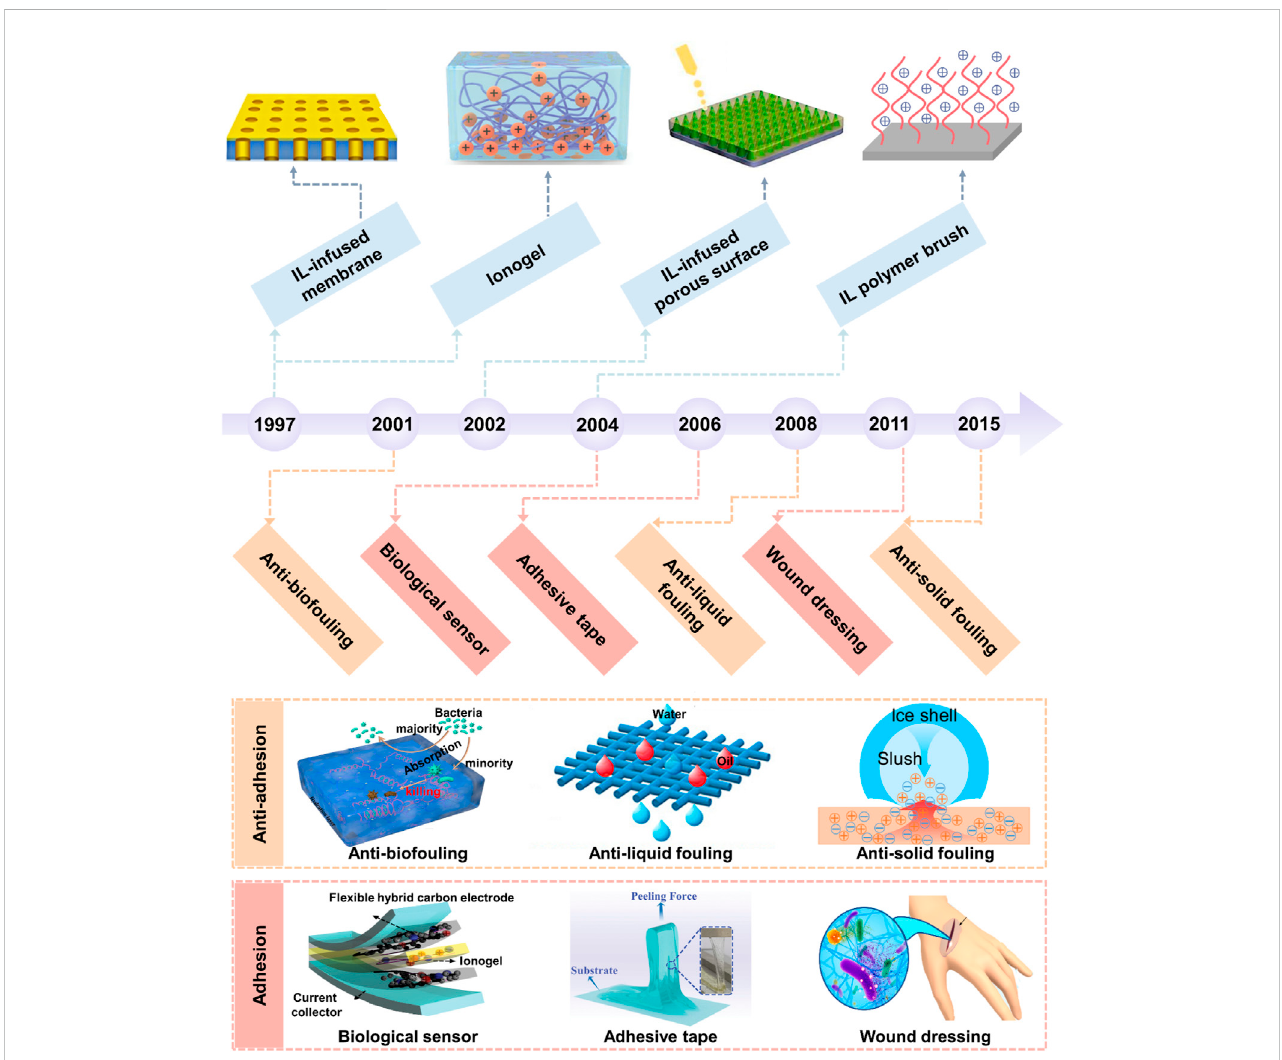
FIGURE 1 MilestonesofthedevelopmentandapplicationofBILIM.ThedevelopmentofILshasgonethroughthreegenerationsrangingfromthe fi rstgenerationof unstable ILs and the second generation of stable ILs to the third generation of functional ILs. There are four main forms of IL-based interfacial materials, including 1D IL polymer brush, 2D IL-infused porous surface and supported membrane, and 3D ionogel. The applications of BILIMs are mainly divided into anti-adhesion (anti-biofouling, anti-scaling, and anti-icing) and adhesion (biological sensor, adhesive tape, and wound dressing). Reproduced with permission (Zhang et al., 2019). Copyright 2019, American Chemical Society. Reproduced with permission (Zhuo et al., 2020). Copyright 2020,